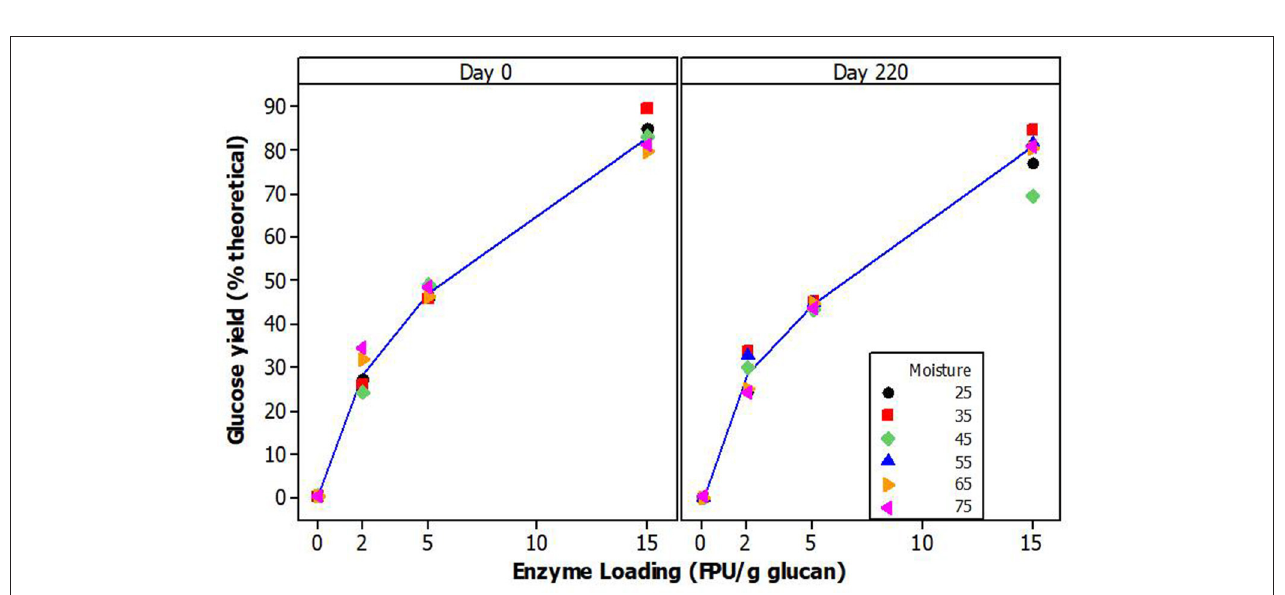
FIGURE 4 | Mean glucose yield (% theoretical) of pretreated washed PA corn stover fiber at different enzyme loadings.